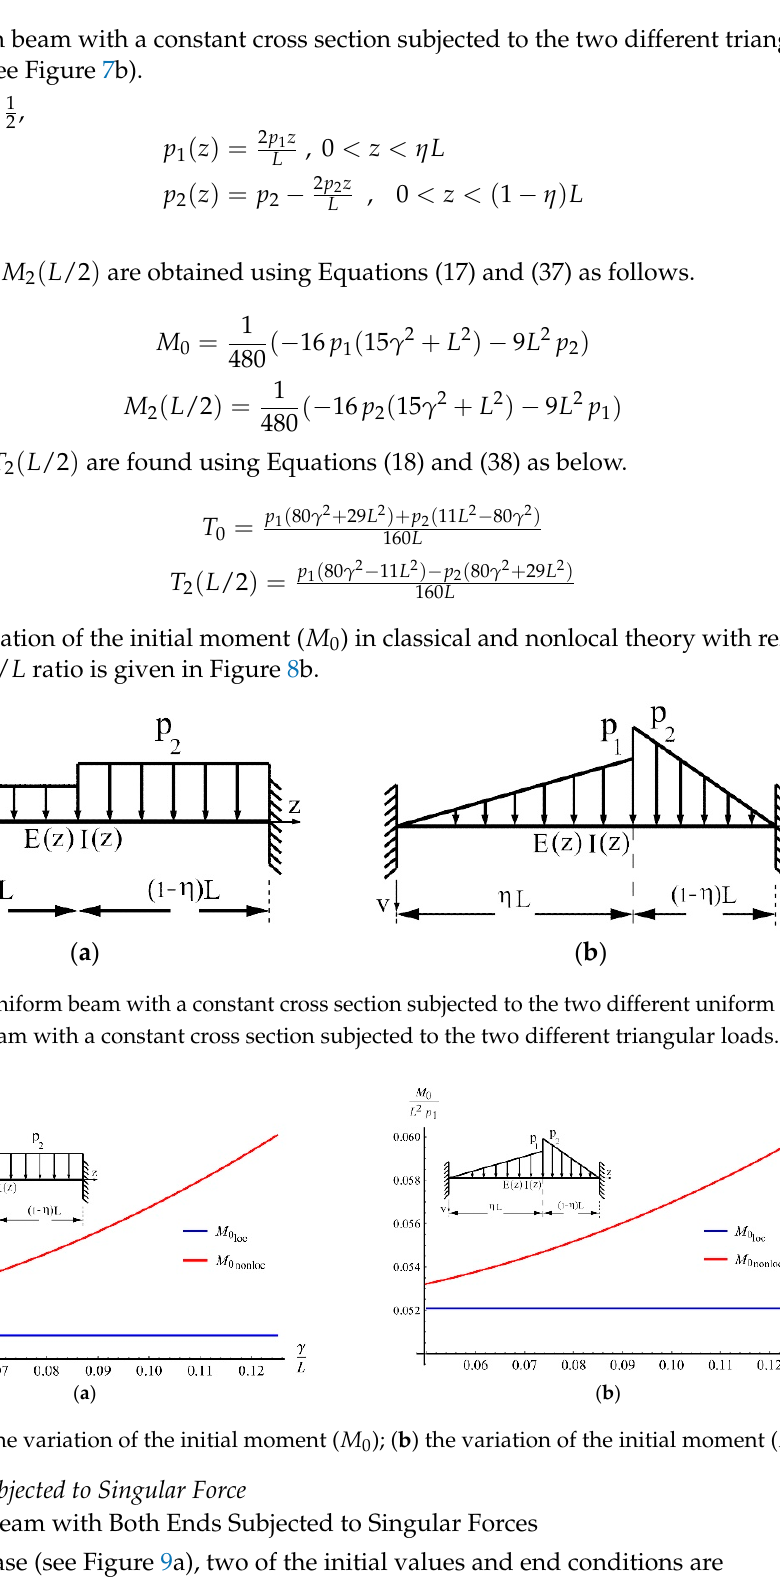
); ( b ) the variation of the initial moment ( 0 M